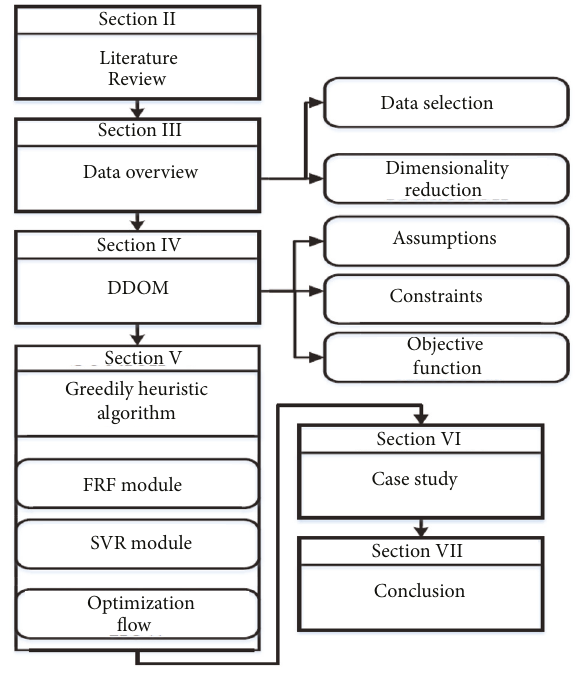
Figure 2: Overall